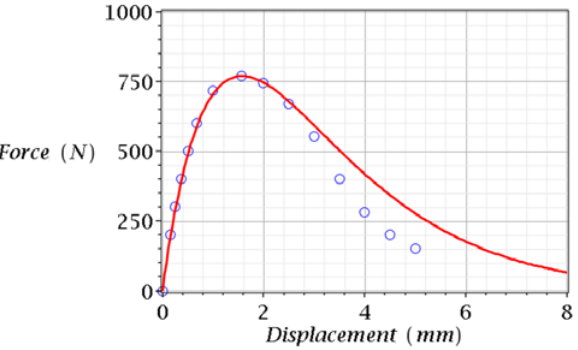
Figure 6. The predicted curve (solid line) and experimental data [9] (circles) for the sample, according to Figures 4 and 5 (frozen sandy loam).